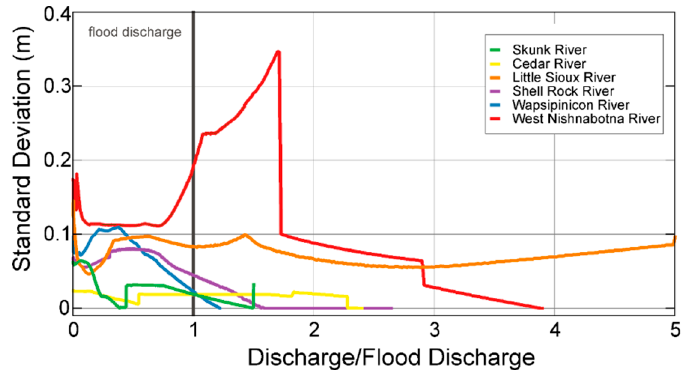
Figure 19. Deviation of the stages for each value of normalized discharge.